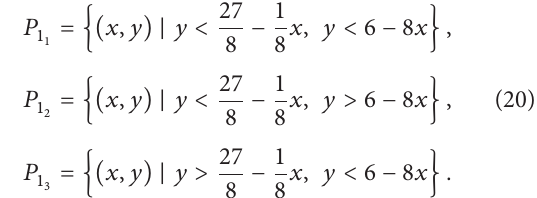
𝑢 5 < 𝑢 8 0 1 is satisfied. Together with inequations (18), the region G is regarded as almost complete defected